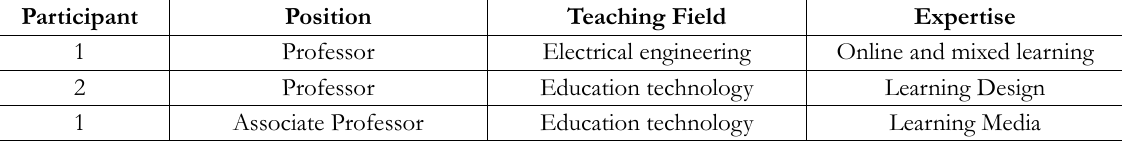
Table 1. Experts Used for the Validation of the Network-Based Online Learning